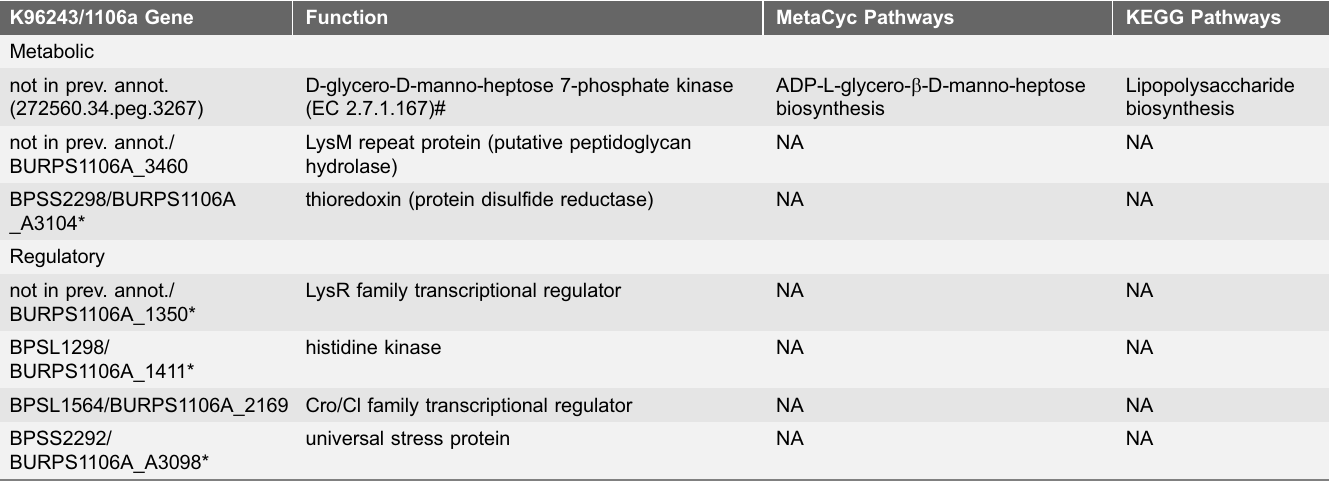
Table 6. Metabolic and regulatory genes in the K96243 and 1106a genomes that were not present in